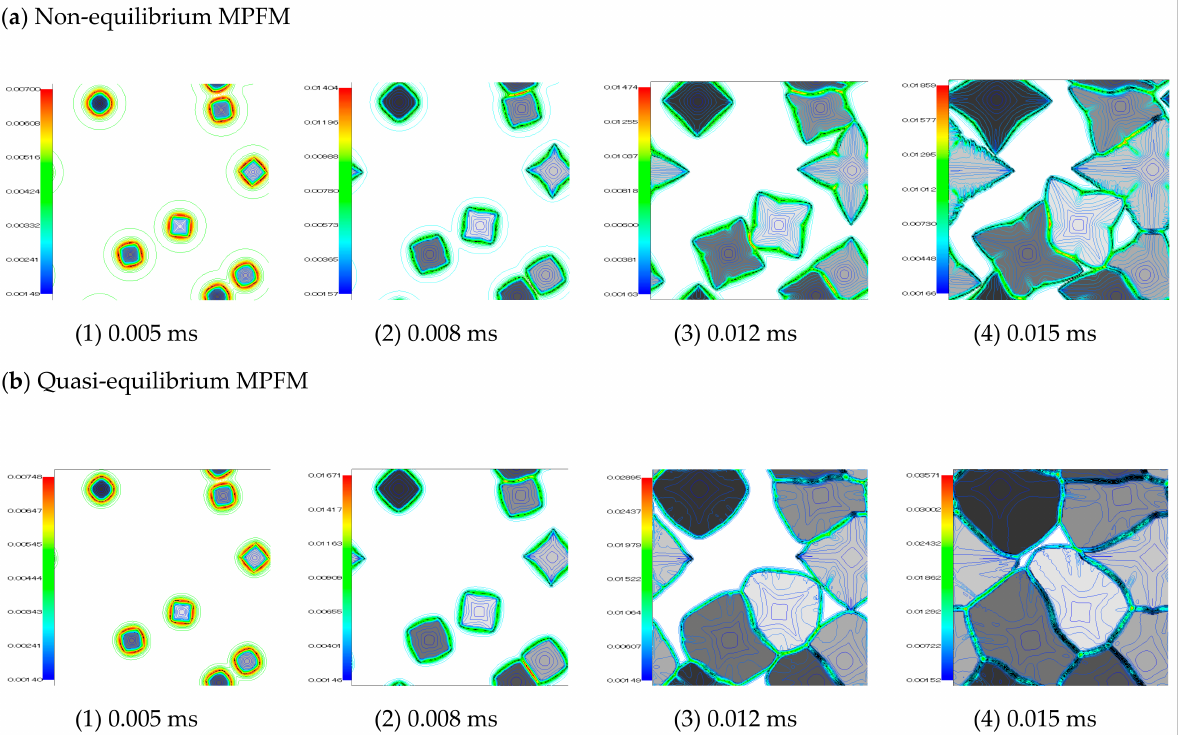
Figure 4. Temporal C concentration (molar fraction) and γ grain distributions obtained at a cooling rate of 10 7 K/s by ( a ) the non-equilibrium MPFM and ( b ) the quasi-equilibrium